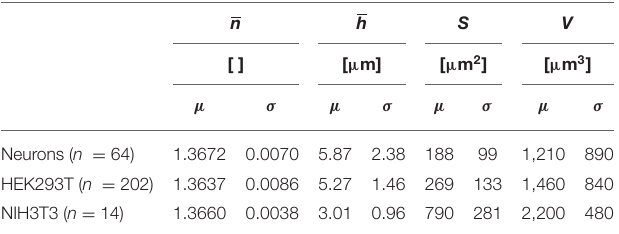
TABLE 1 | Measured biophysical parameters on populations of primary neurons, HEK293T, and NIH3T3 cells during their resting